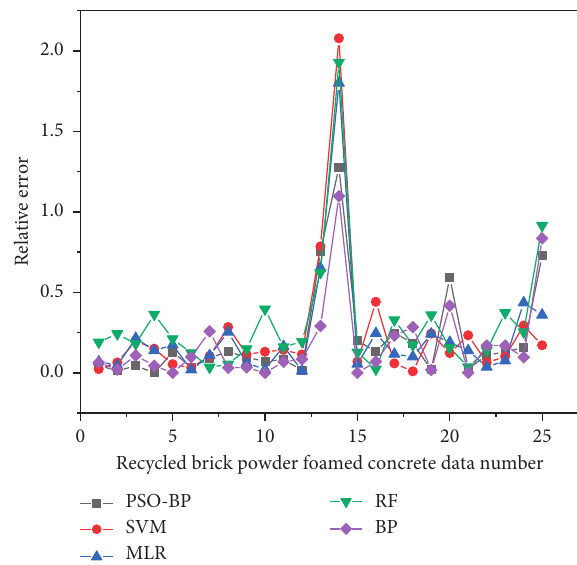
Figure 13: Relative error plots for each